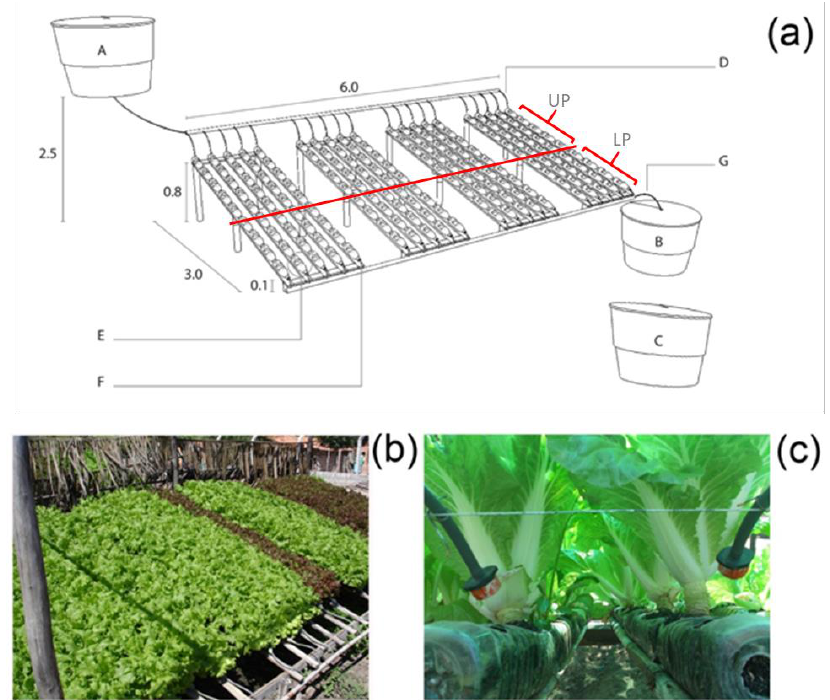
Figure 1. ( a ) Schematic drawing of the growing system used with measurements (in meters) adopted. The system includes a top (A) and a drainage (B) tank, as well as a fresh nutrient solution reservoir (C). The system is fitted with a gravity flow drip-irrigation system (D) that deliver the nutrient solution to 20 lines of recycled plastic bottles (E). Excess nutrient solution is then drained to a re-collection pipe (F) which is connected (G) to the drainage tank (B). UP = Upper position; LP = Lower position. Images of the systems in the cities of ( b ) Teresina (Piaui, Brazil) and ( c ) NayPyiTaw (Myanmar). Table 1. Macronutrient concentrations in water and nutrient solutions (NS) adopted in the experiments in NE-Brazil and in CDZ-Myanmar.